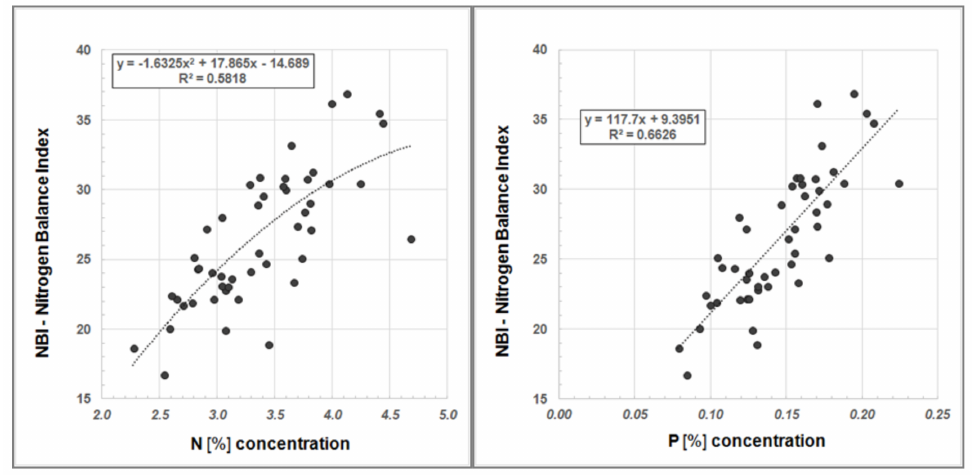
Figure 6. Regression analysis between NBI and N content ( left ) and between NBI and P concentration ( right ) in Robinia leaves.